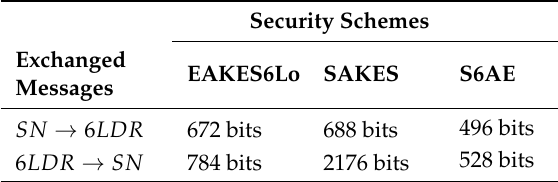
Table 7. Communication overhead.